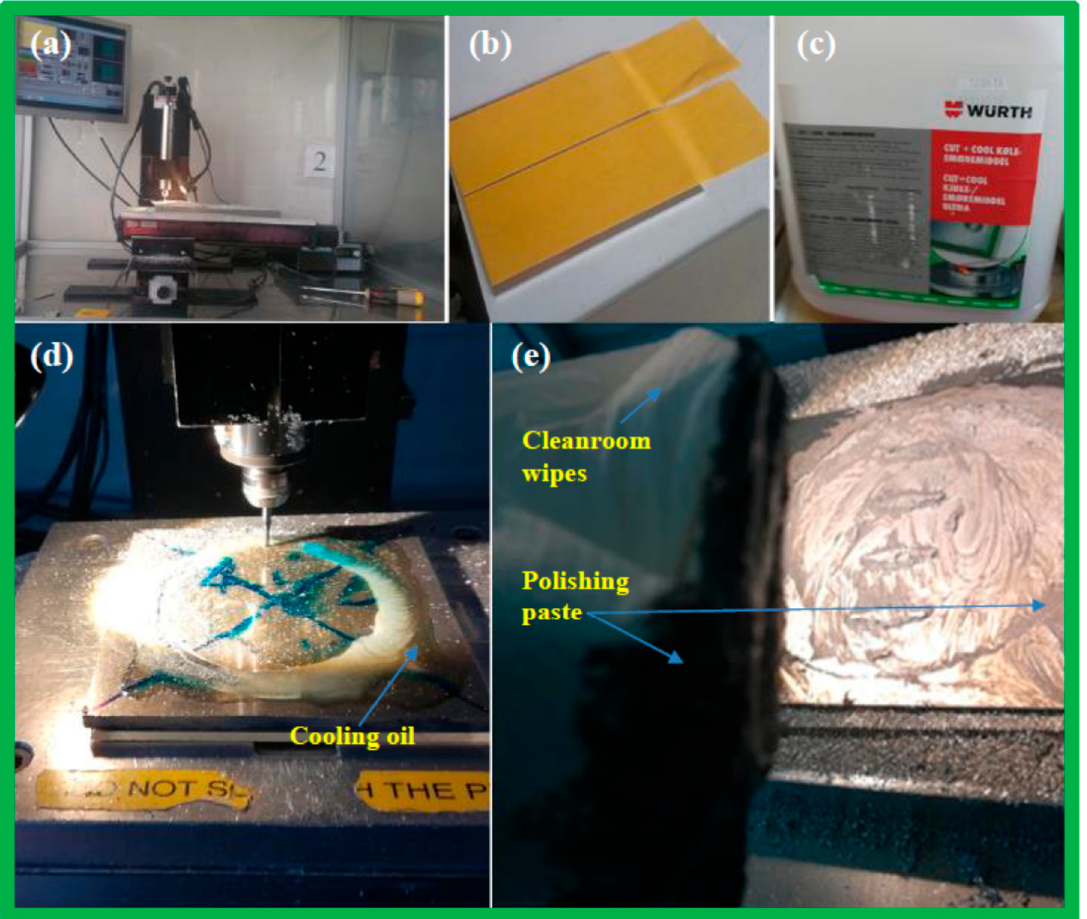
Figure 4. ( a ) Milling machine, Minitech Machinery Corporation, Norcross, GA, US (minimill 3); ( b ) the double-sided tapes that hold the Al plate in place during the milling stage; ( c ) cooling oil from Wurth, Künzelsau, Germany; ( d ) cooling oil is applied to the surface before the milling; ( e ) Autosol Aluminum polishing paste is applied after the bulk milling and cleanroom paper is used.